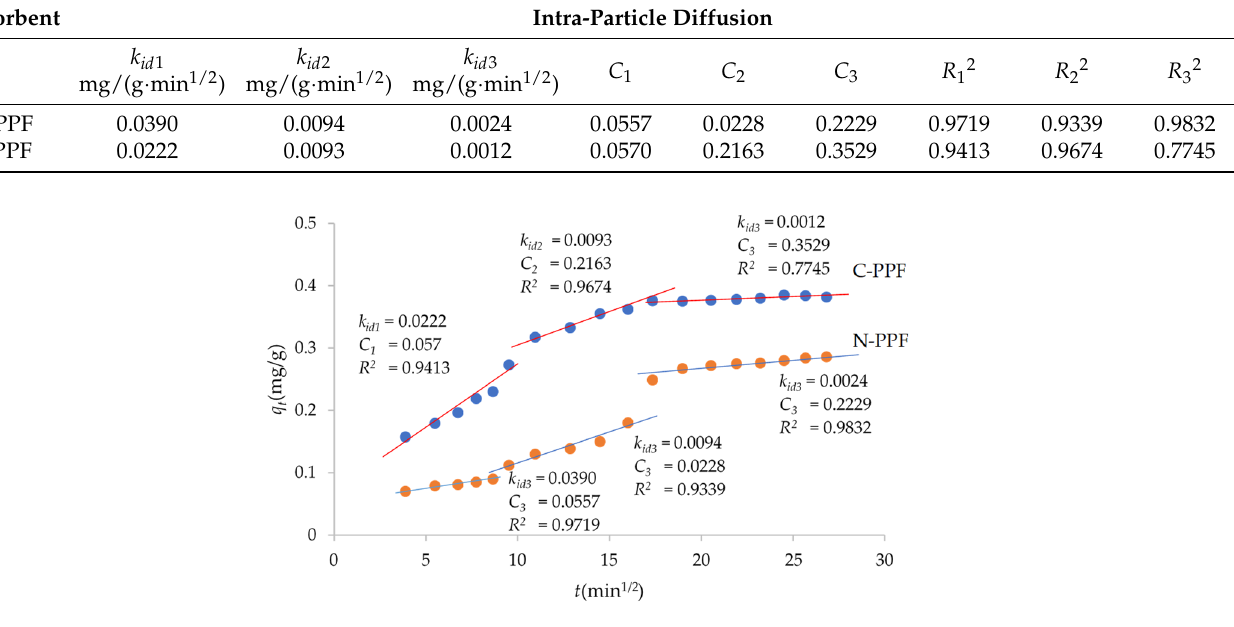
Figure 16. Intra-particle diffusion model for Fe(III) adsorption of C–PPF and N–PPF.